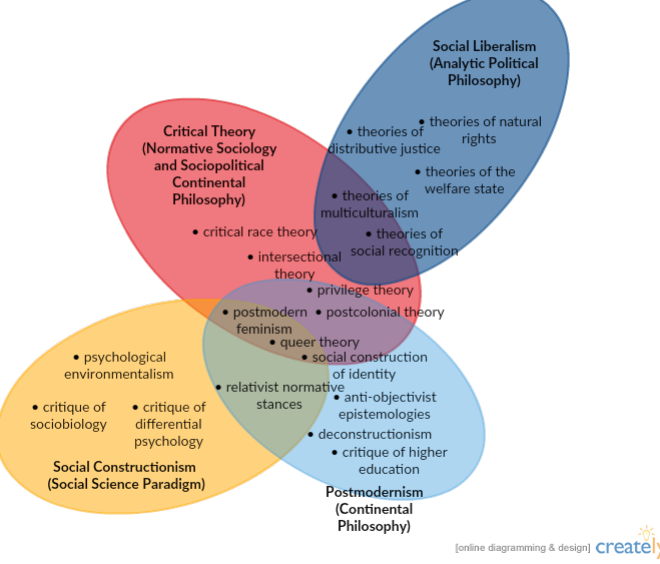
Figure 1. The Intersectional Paradigms of the politically correct (PC)